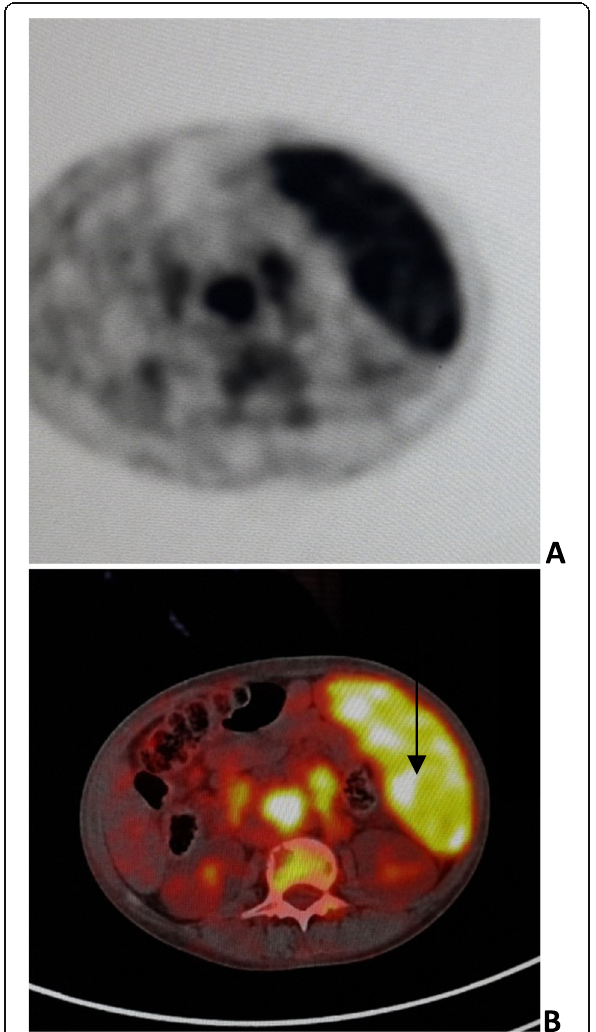
Fig. 3 A 45-year-old female patient with history of NHL presented with diffuse splenomegaly a axial PET image and b corresponding axial PET/CT fused image showing diffuse avid splenic uptake exceeding the hepatic uptake and pathologically proven to be lymphomatous infiltration (black arrow in b )